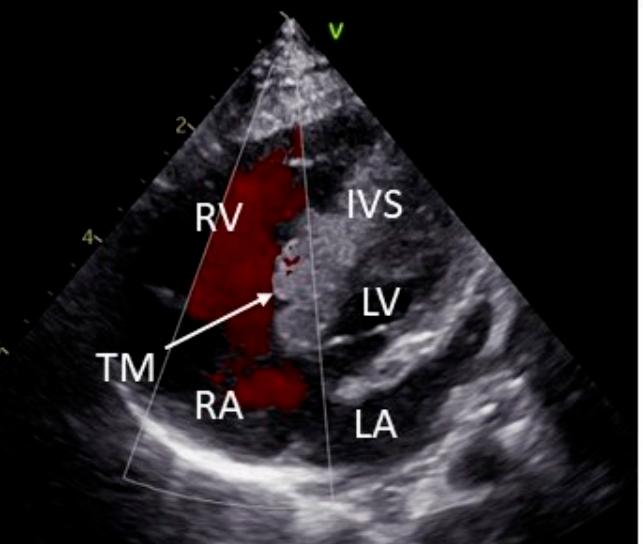
Figure 4. Echocardiografic four-chamber view at age of 2 months showing further reduction in the right ventricular tumor size during specific therapy. The tricuspid valve is tumor-free. IVS: interventricular septum; LA: left atrium; LV: left ventricle; RA: right atrium; RV: right ventricle; TM: tumor.